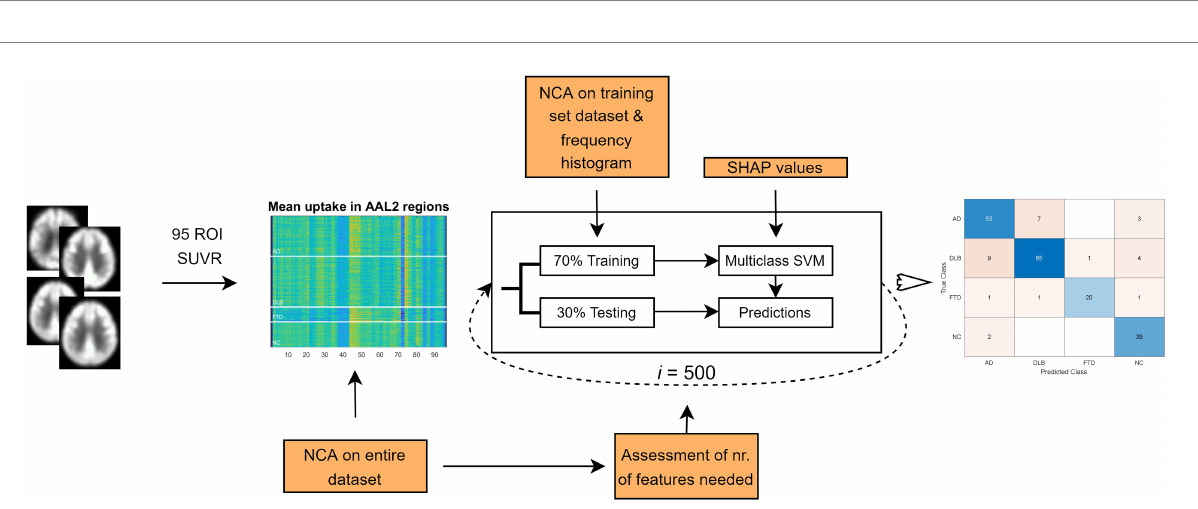
FIGURE 5 Flowchart depicting three different approaches to the explanation of the model. Initially, we used the entire dataset and assessed feature importance using neighborhood component analysis (NCA). The weights were used to rank the features from most to least important. NCA was then performed separately on just the training set for each iteration, and the retained features were plotted on a frequency histogram. To explain the support vector machine (SVM) model we employed Shapley Additive Explanations (SHAP). ROI, region of interest; SUVR, standard uptake value ratio; AAL, automated anatomic labeling